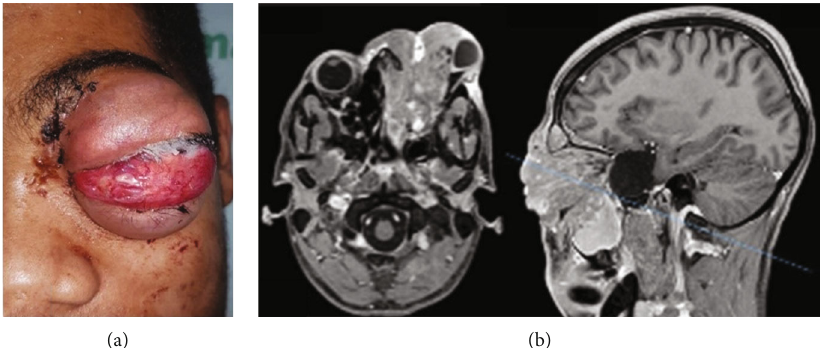
Figure 1: Clinical and imaging features. (a) Extraoral examination showed exophytic and expansive lesion around orbital region. (b) MRI axial and sagittal slices demonstrated tumor invasiveness into the periorbital region, sinonasal tract, left maxilla, and orbit roof.